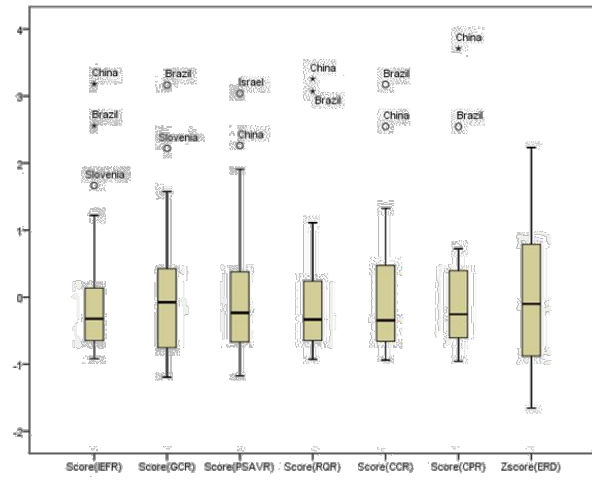
Figure 5. Bloxpot of the Macroeconomic Variables of the 30 Most Innovative Countries and Brazil for 2015.